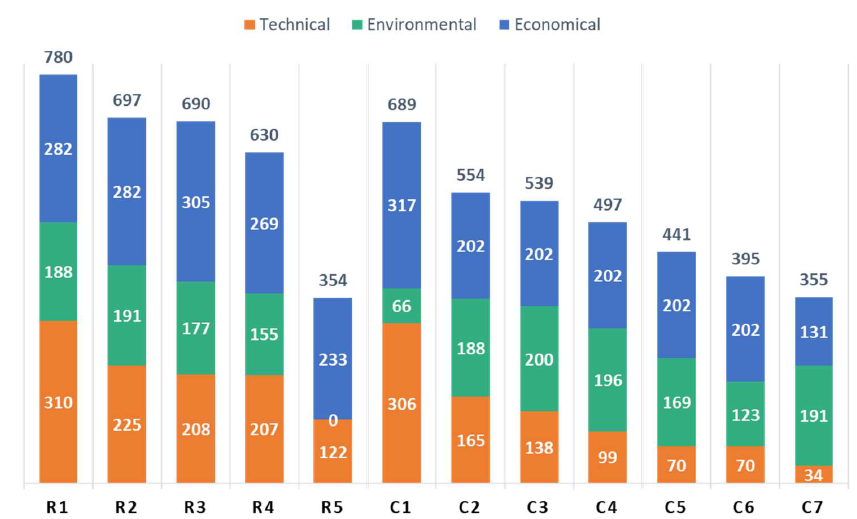
Figure 3. Sustainability Potential Indexes for the assessed scenarios.